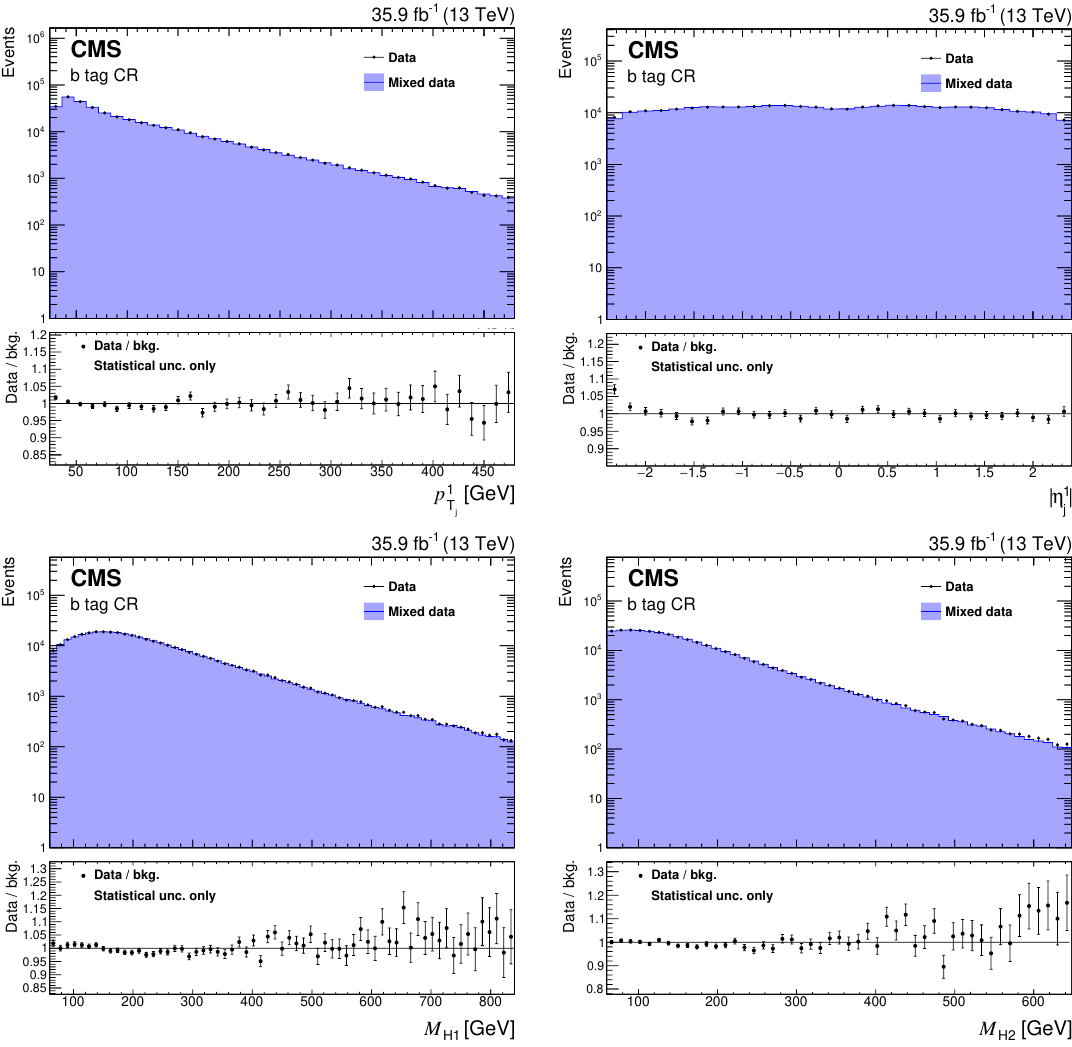
Figure 5 . Comparison between the background model obtained with the hemisphere mixing tech- nique and data in the b tag CR for the variables p T1 (upper left), (cid:17) 1 (upper right), M H (lower left), j j 1 and M H (lower right). Bias correction for the background model, described in section 8.2, is applied 2 by rescaling the weight of each event using the event yield ratio between corrected and uncorrected BDT distributions in this CR. Only statistical uncertainties are shown as the uncertainties related to the bias correction can not be propagated from the BDT classi(cid:12)er to a di(cid:11)erent